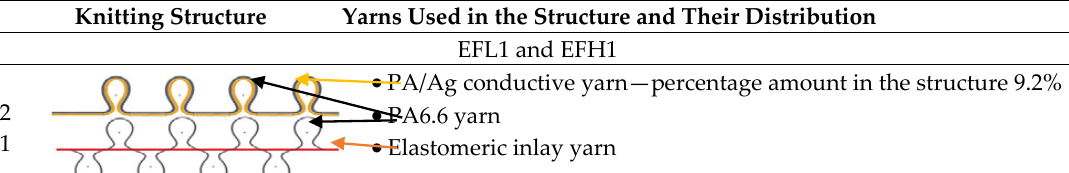
Table 1. Knitting structures and distribution of electro-conductive yarn in the knitting pattern. Knitting